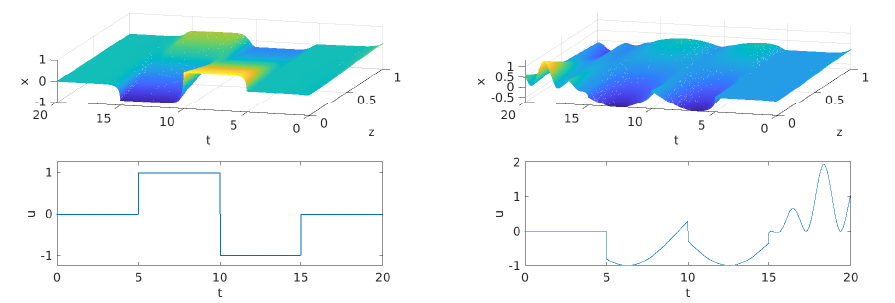
Figure 7. Input scenarios for S1, S2 (left, u = u 1 ) and S3, S4 (right, u = u 2